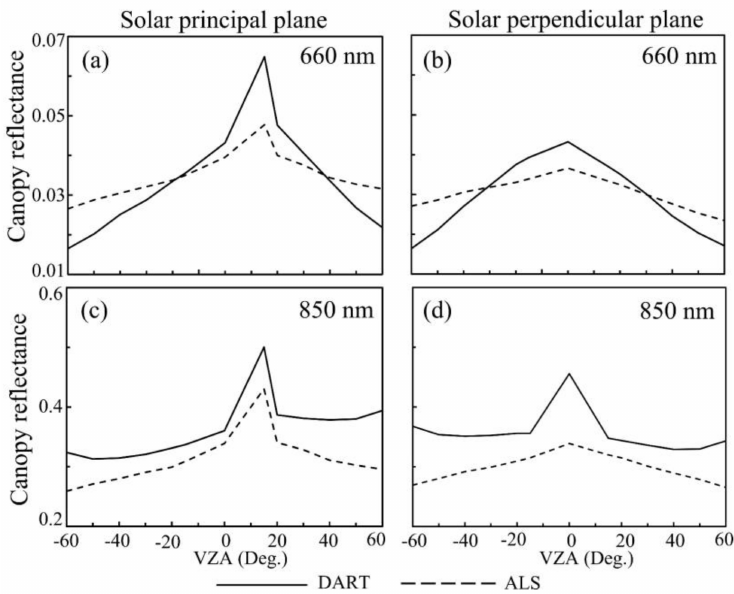
Figure 10. Comparisons between ALS- and discrete anisotropic radiative transfer model based forest canopy reflectance values in red (insets a , b ) and near-infrared (insets c , d ) bands with the view zenith angles ranging from –60 ◦ to 60 ◦ in solar principal and perpendicular planes for forest plot WPA-P2. The solar zenith and azimuth angles are 37 ◦ and 150 ◦ ,